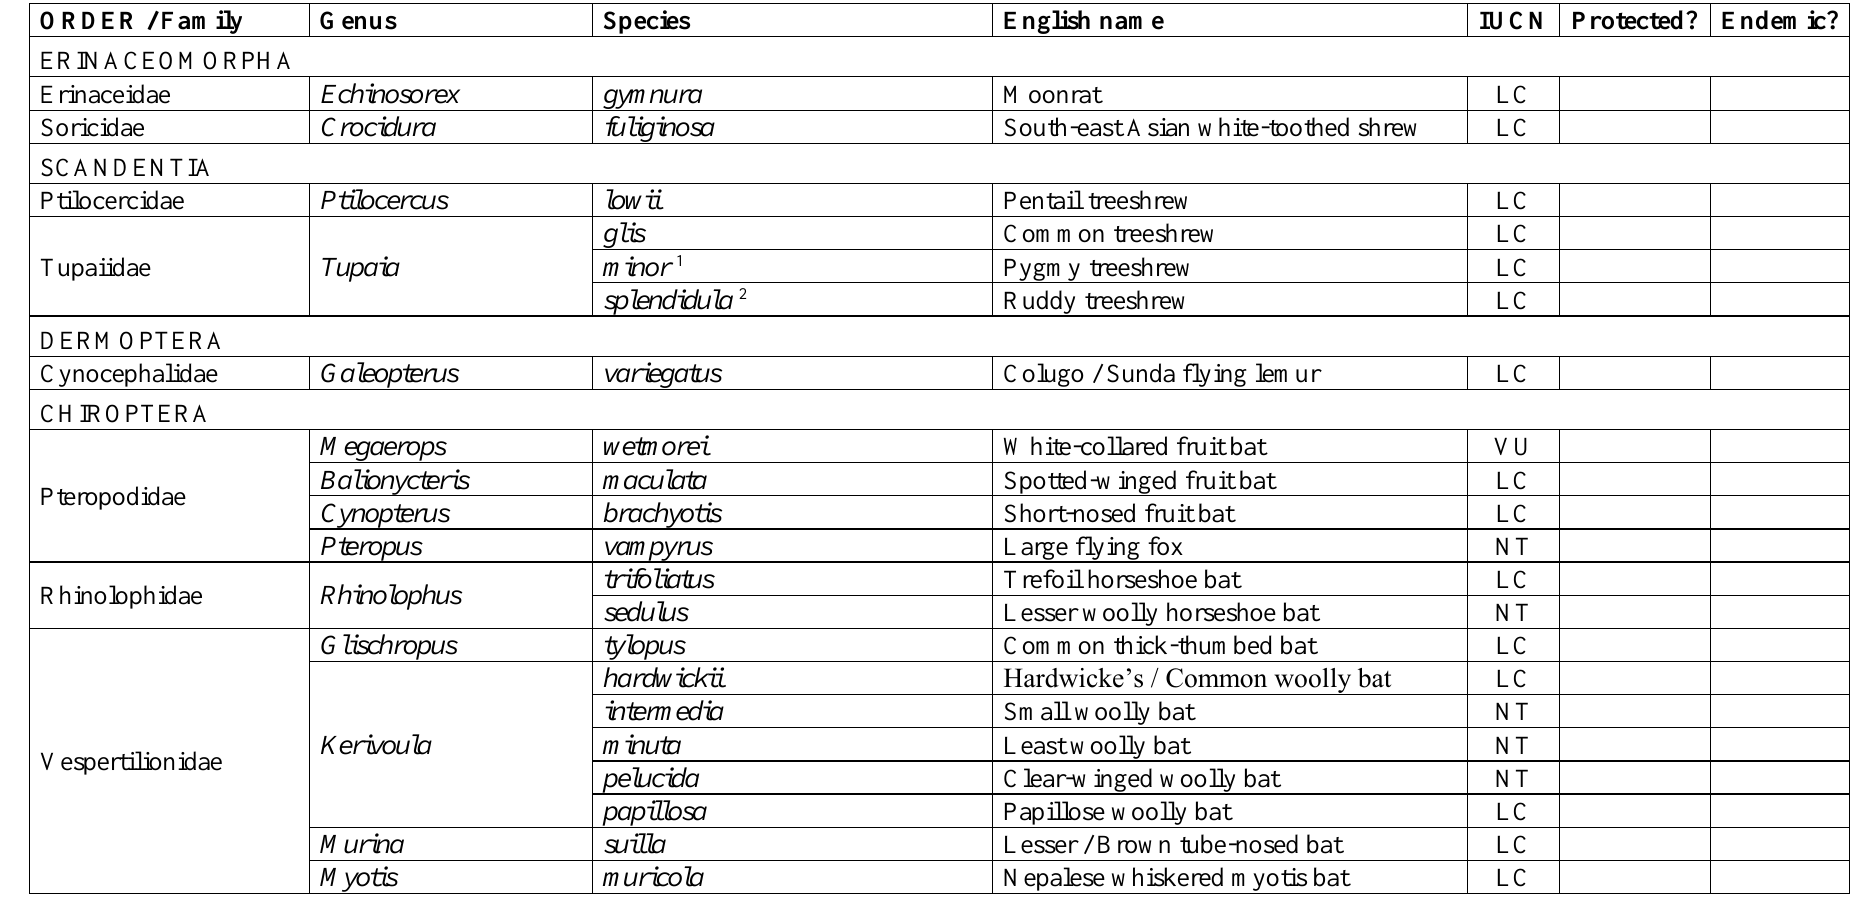
Table A10. List of mammal (Mammalia) species recorded in the NLPSF, Sebangau, together with IUCN Red List classifications (CR = critically endangered; DD = data deficient; EN = endangered; LC = least concern; NT = near threatened; VU = vulnerable), Indonesian protected species listings and Borneo endemic species assignments. Parentheses for Latin names indicate synonyms. For English names, parentheses indicate optional parts of the name and slashes indicate alternative names. Bat species records from Struebig et al.